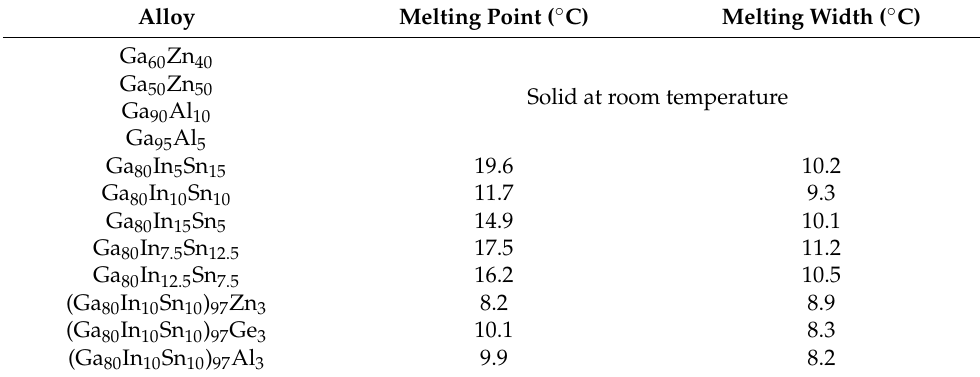
Table 2. Gallium-based alloy melting point with di ff erent elements (each value in the metal column Table 2. Cont. means weight percentage.).